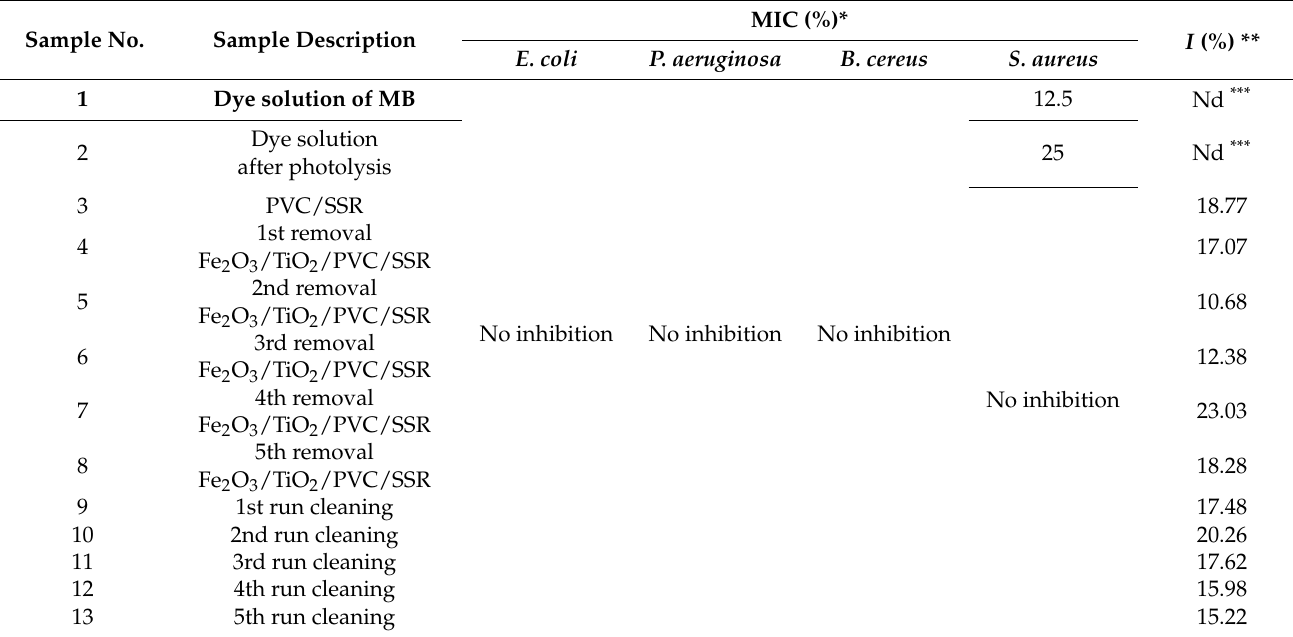
Table 4. The antibacterial activity of treated water solutions and cleaning solutions determined as minimal inhibitory concentration (MIC) by microdilution method and inhibition percentage I (%) by Pseudomonas putida growth inhibition